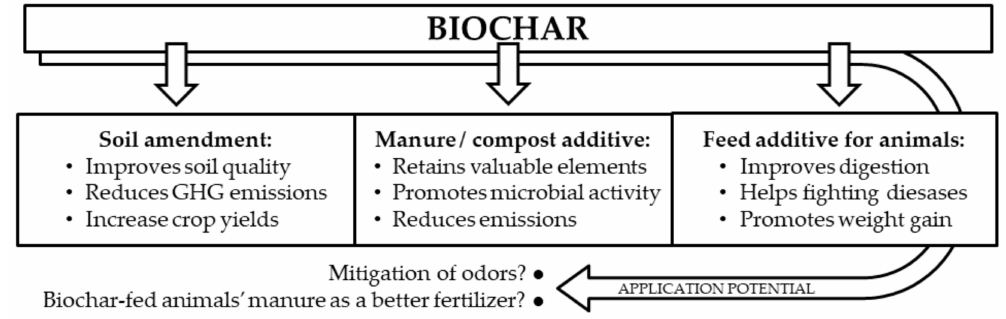
Figure 1. Summary of the scope and content of review focused on the use of biochar in